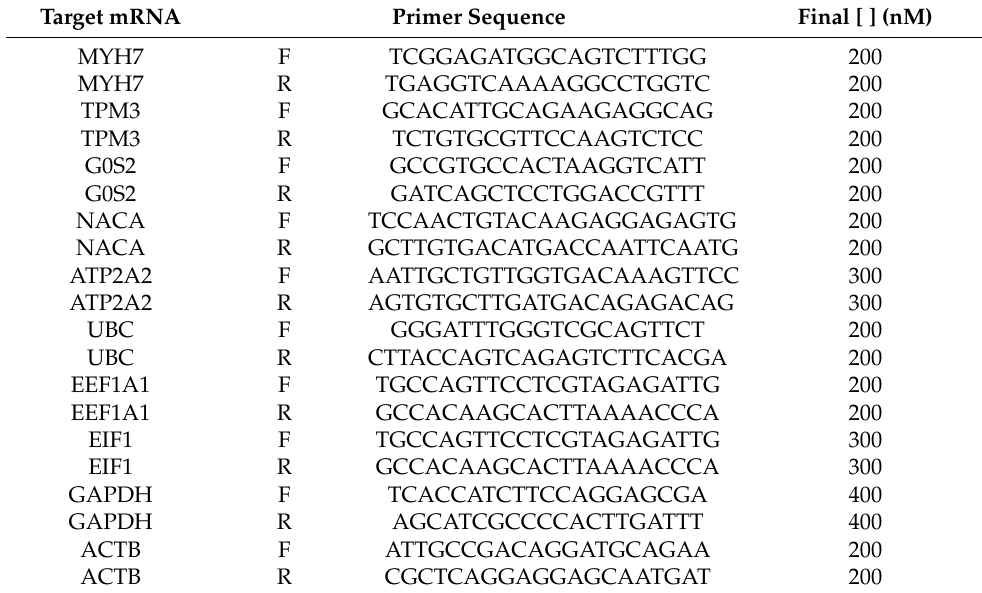
Table 3. Primers designed using Primer-BLAST for use in real-time PCR assays. Target mRNA Primer